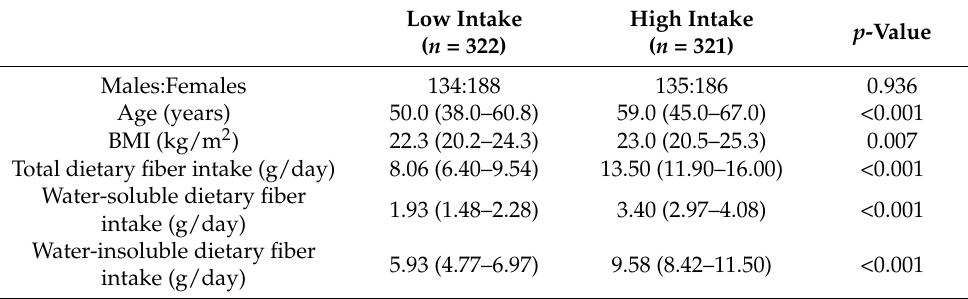
Table 1. Participants’ characteristics at baseline. Number or median (range).